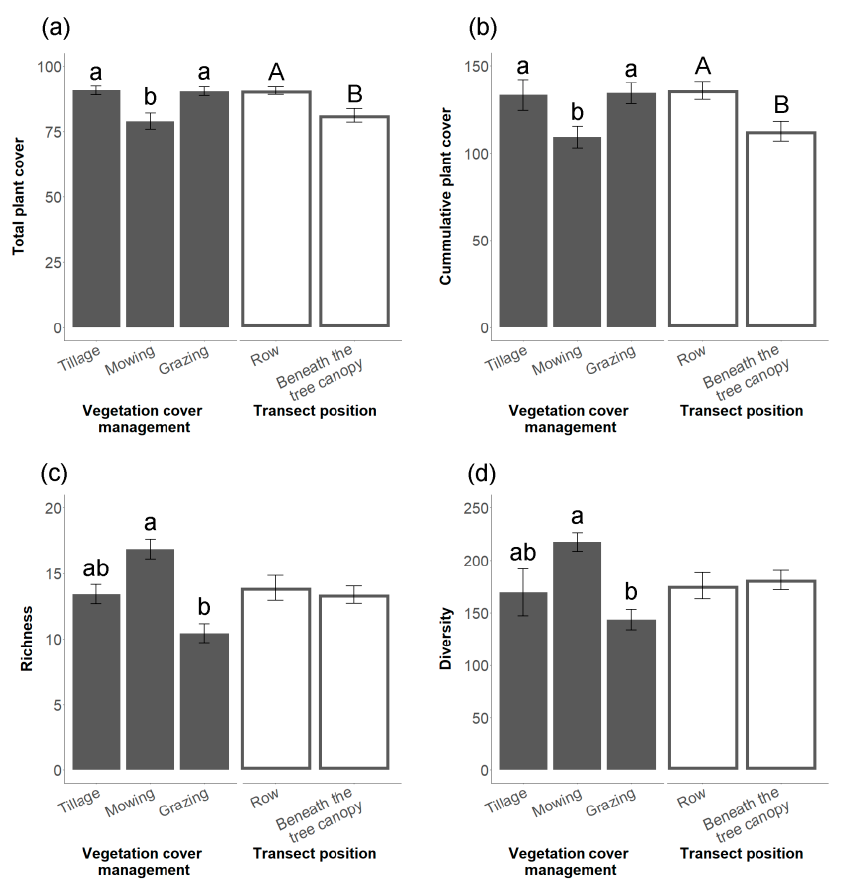
Figure 1. Vegetation indices (mean ± SE): total plant cover (%), cumulative plant cover (%), richness and diversity of the cover vegetation ( a – d ), respectively, for the vegetation cover management and transect position. Different letters indicate statistically significant differences between the vegetation cover management or transect position ( p <